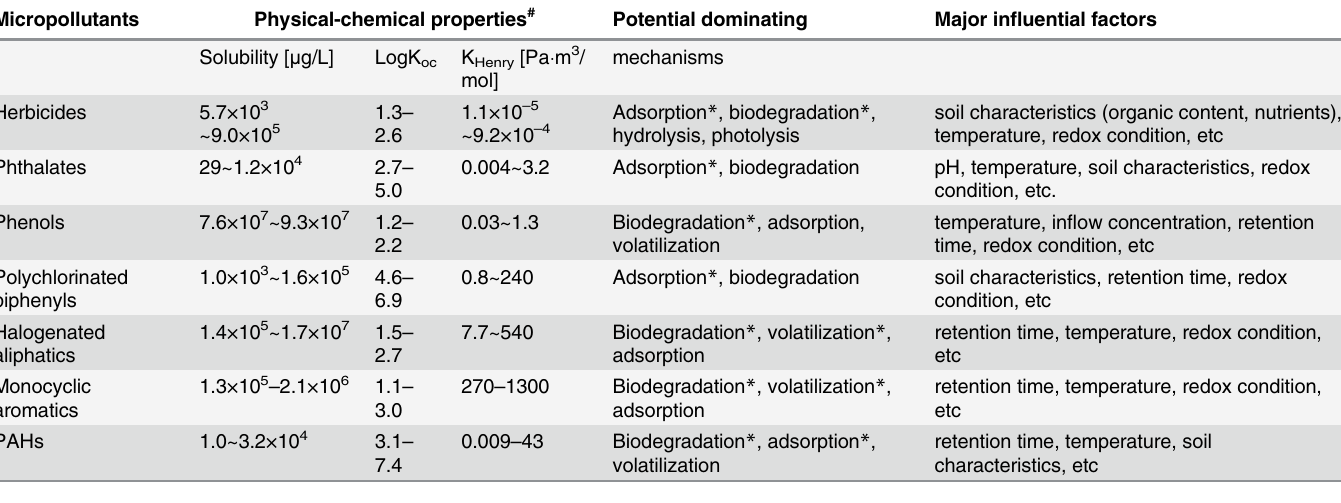
Table 4. Physical-chemical properties of different micropollutant groups and their potential removal mechanisms and influential factors. Micropollutants Physical-chemical properties # Potential dominating Major in fl uential